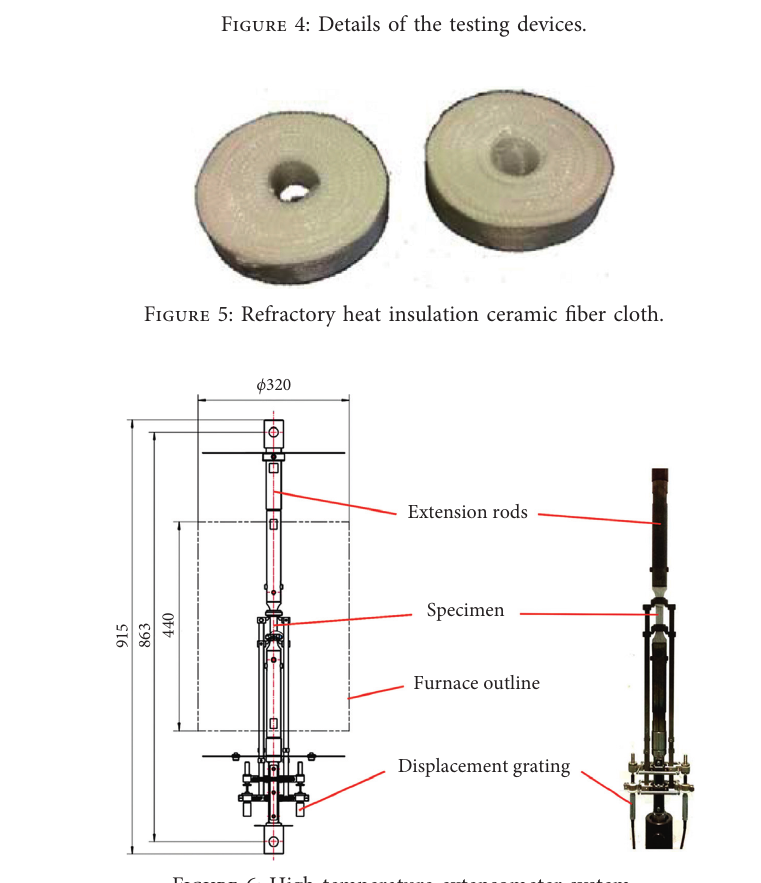
Figure 4: Details of the testing devices.